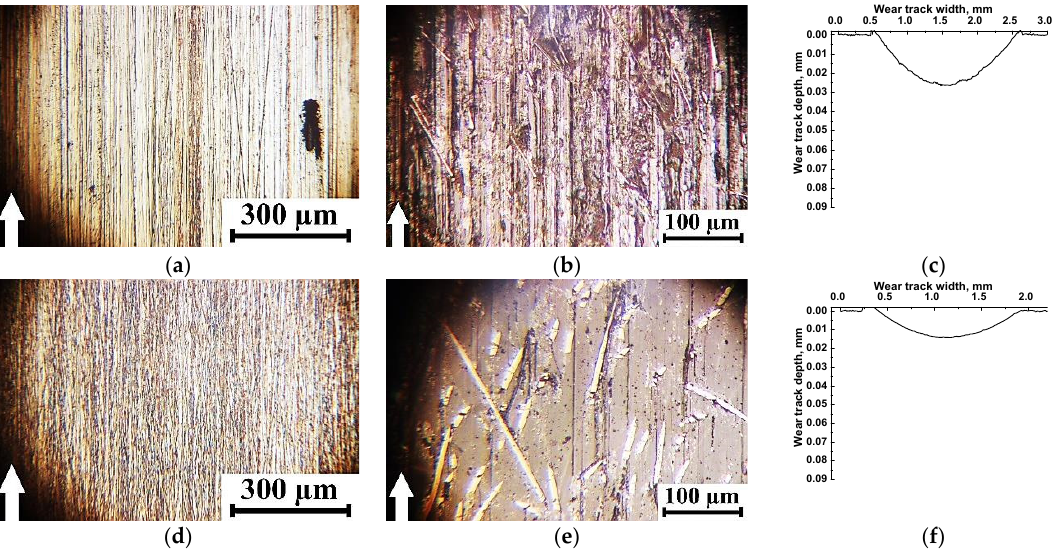
Figure 9. Optical photographs of the steel counterpart surfaces ( a , d ), wear tracks ( b , e )and their profiles ( c , f ) after the tribological tests of the PI/10CCF/1CNT ( a – c ) and PI/10CCF/1HNT ( d – f ) nanocomposites. Linear tribological contact. P = 60 N, V = 0.3 m/s.